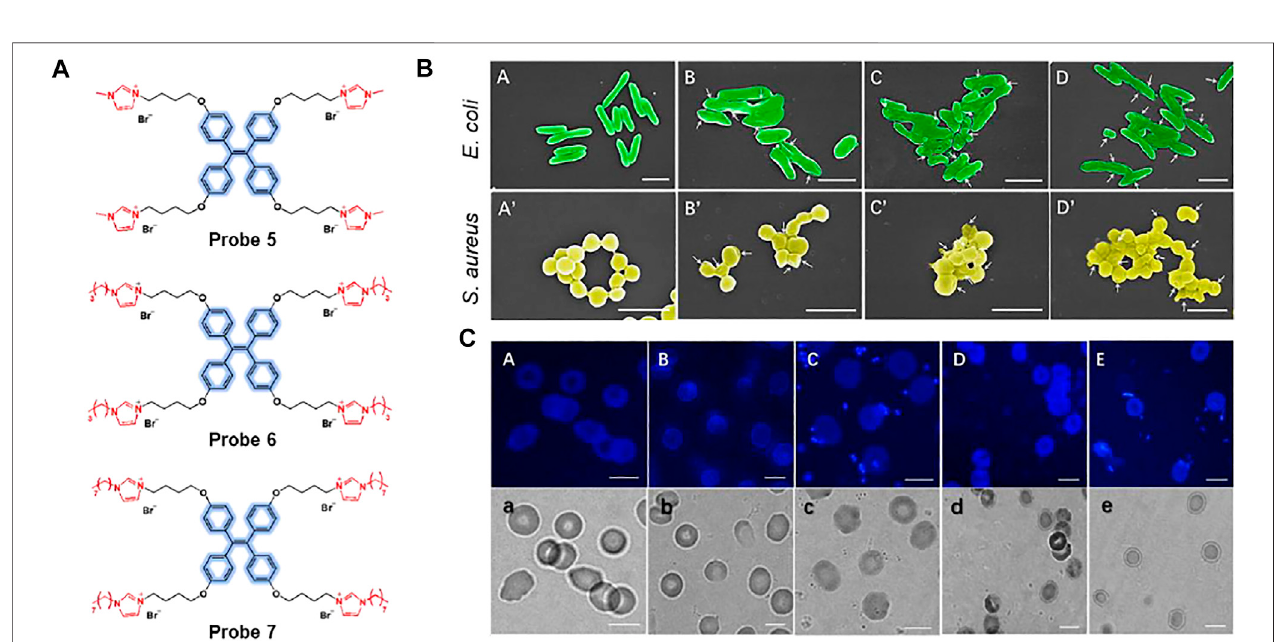
FIGURE 3 | Chemical structure of probe